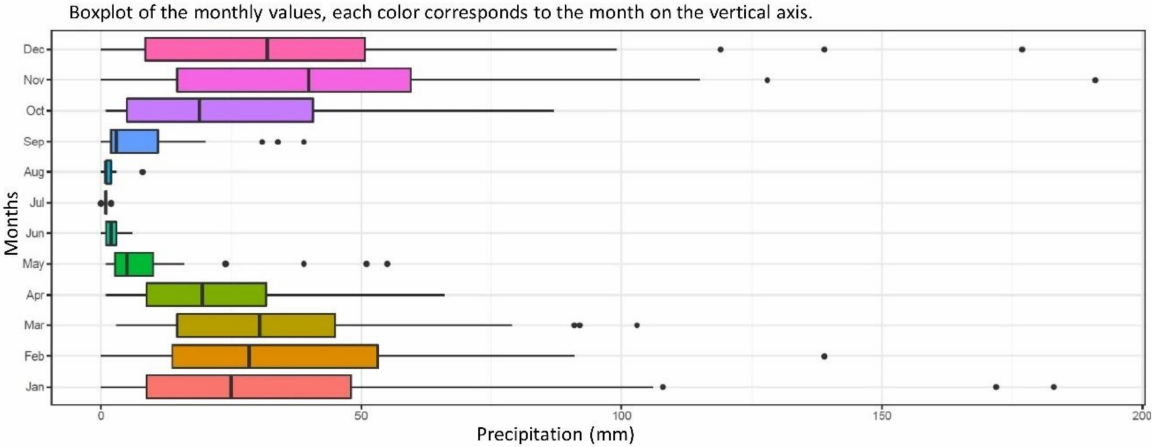
Figure 5. Boxplot of monthly values between 1979 and 2019.